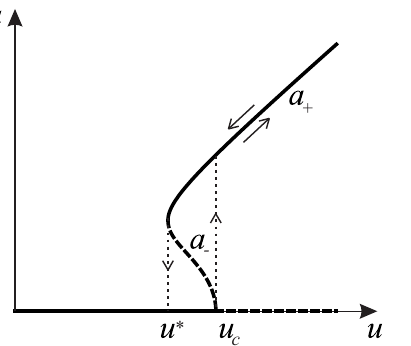
Figure 2. Qualitative galloping response to smooth flow, and hysteresis loop, for prismatic bodies with a 2:1 side